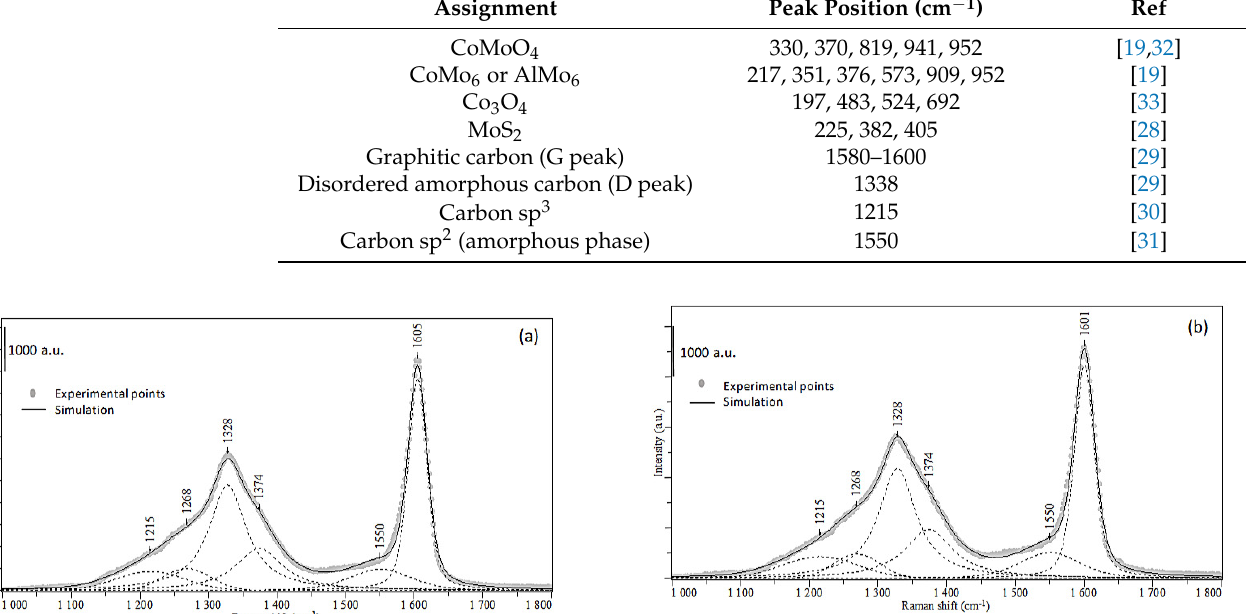
Figure 5. Raman spectrum of the spent catalyst ( a ) and extracted coke by HF ( b ), with the corresponding curve fitted bands.